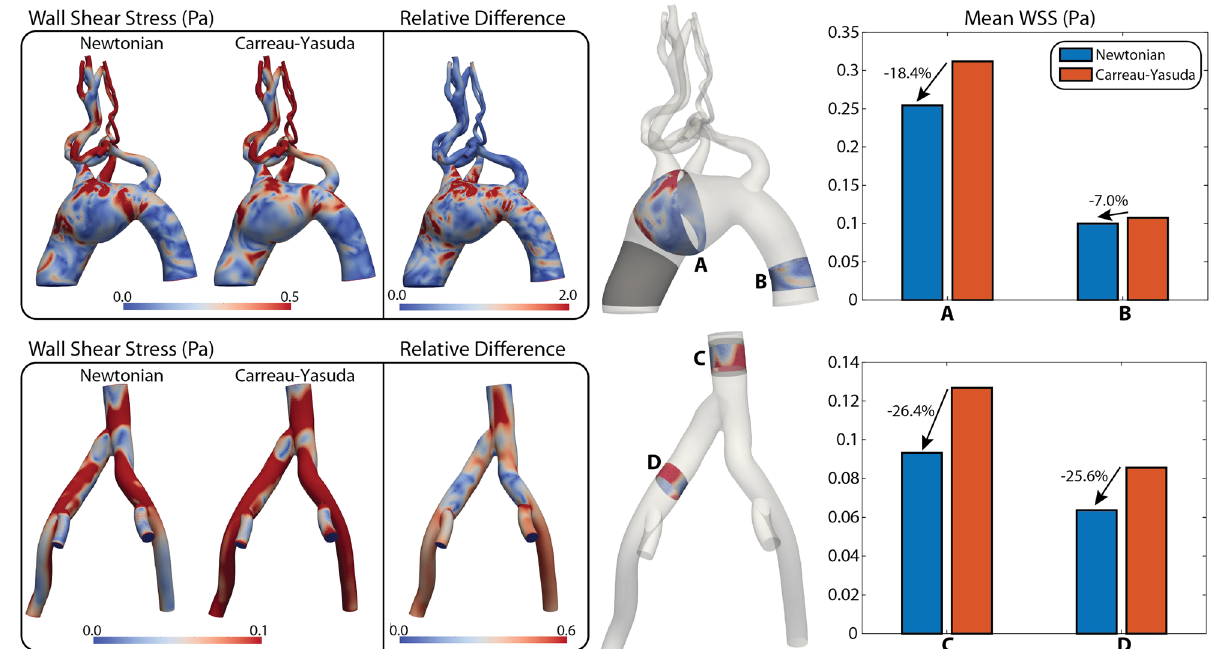
Figure 4. Arterial and venous WSS in diastole. (Left) Contour plots of WSS magnitude for the Newtonian and Carreau-Yasuda models, and relative difference between the two. (Right) Bar plots of mean values for four representative locations ( A – D